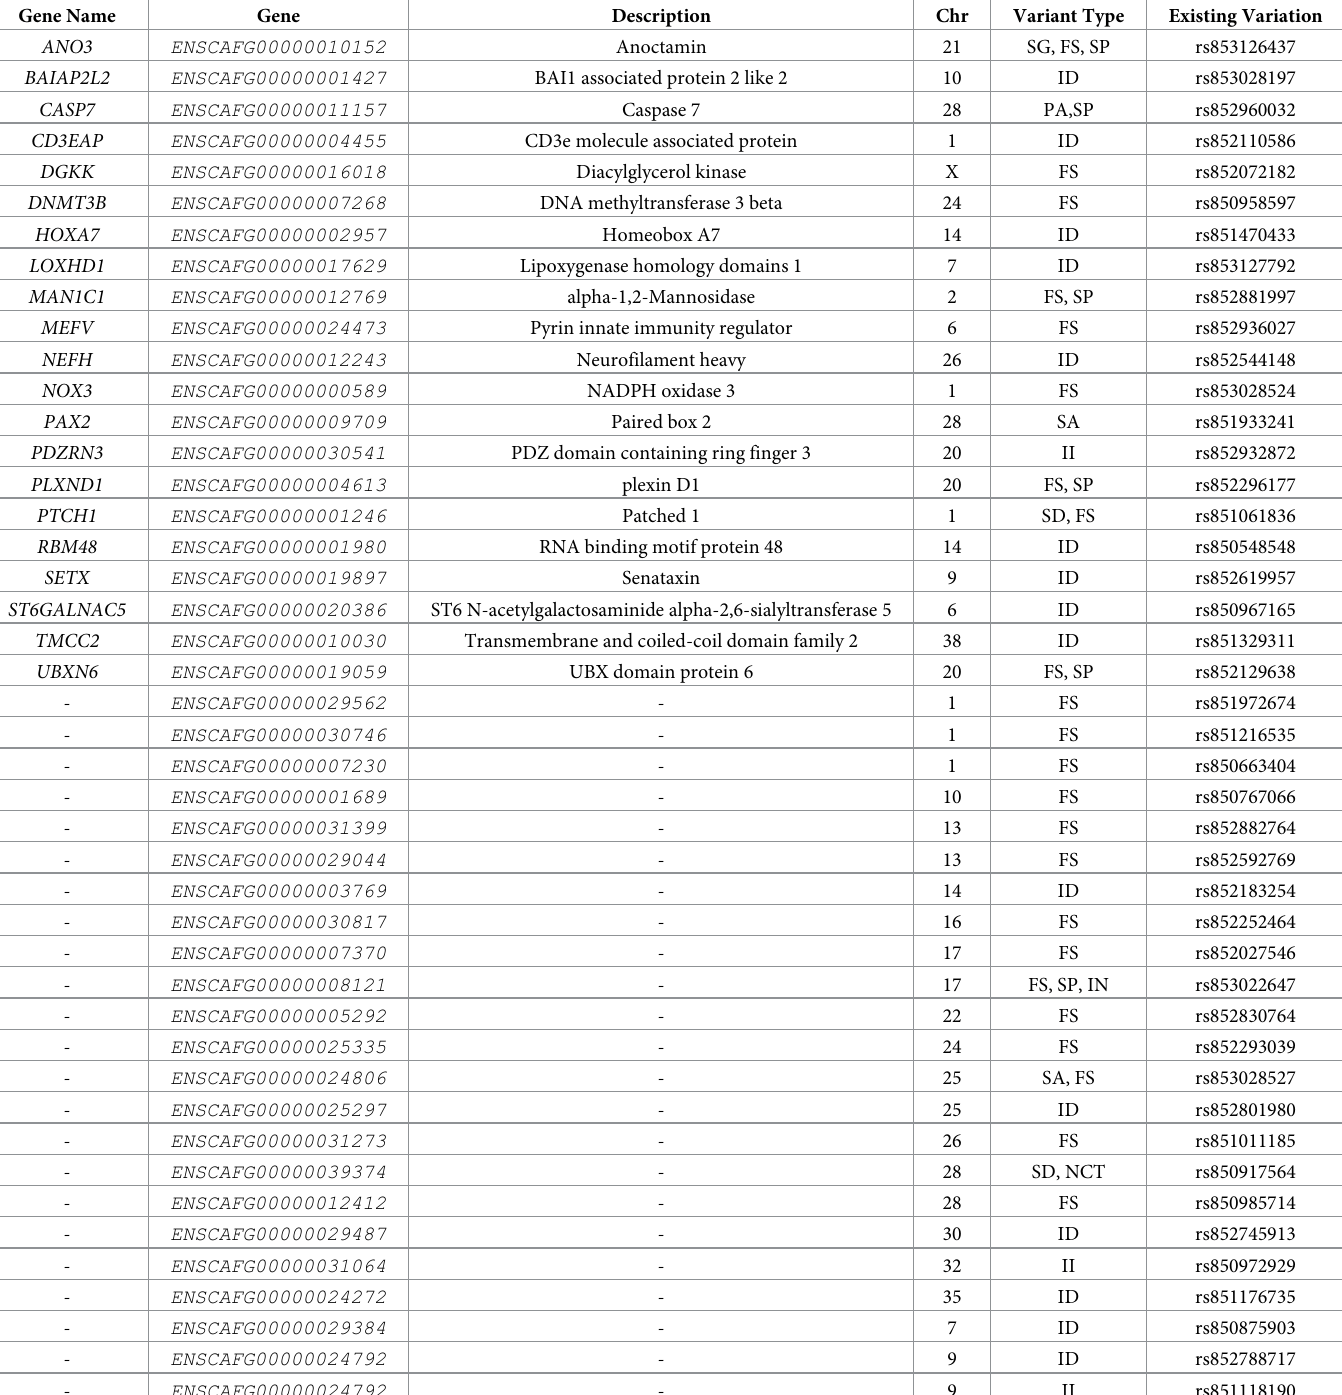
Table 2. High/moderate impact gene mutations found in CL patients with existing, defined variant